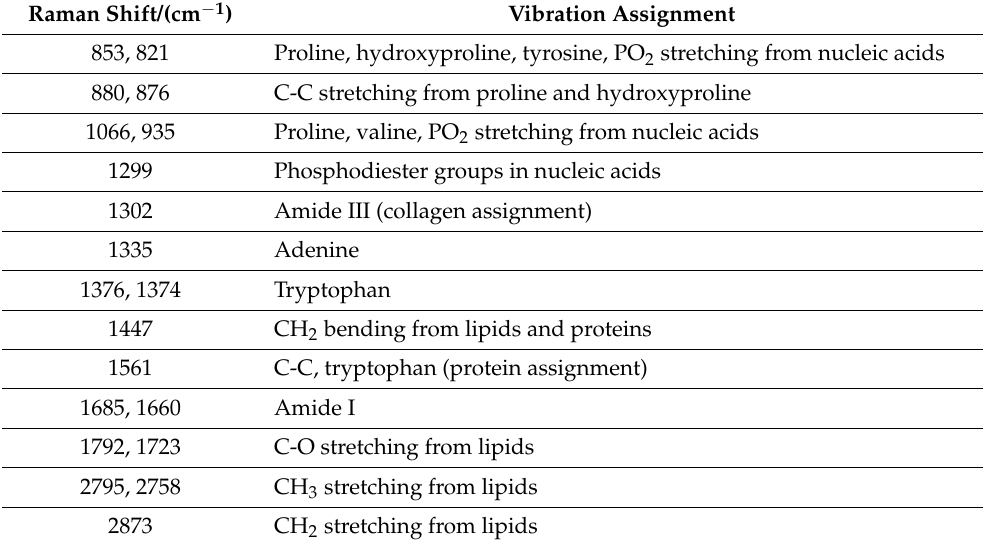
Table 3. Raman shift, with corresponding vibrations described in endometrioid adenocarcinoma